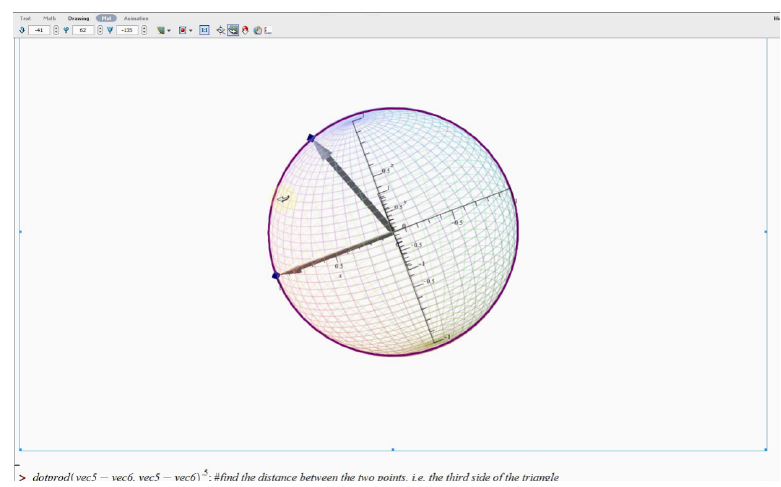
Figure 1: Video in Maple on Great Sphere Distances